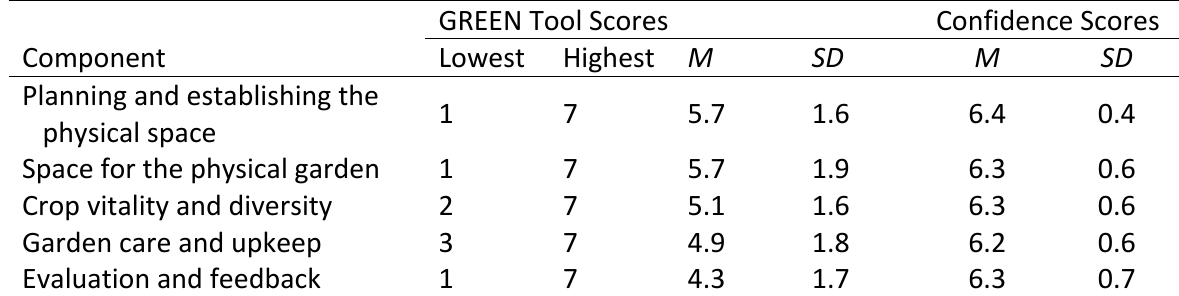
Summary and Comparison of GREEN Tool and Confidence Scores for Domain 2 (n = 15) GREEN Tool Component